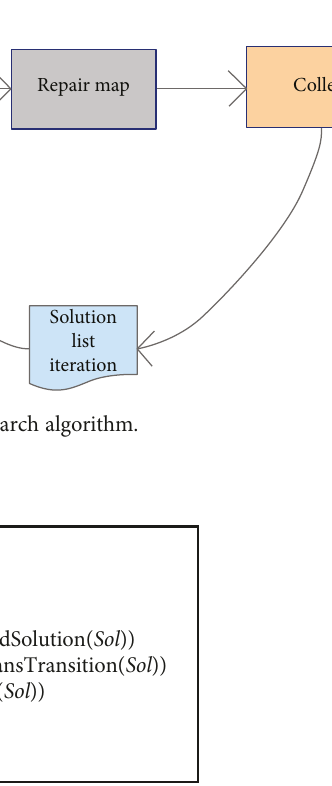
Algorithm 6: Distributed operator. Table 1: SCP instances from Beasley ’ s